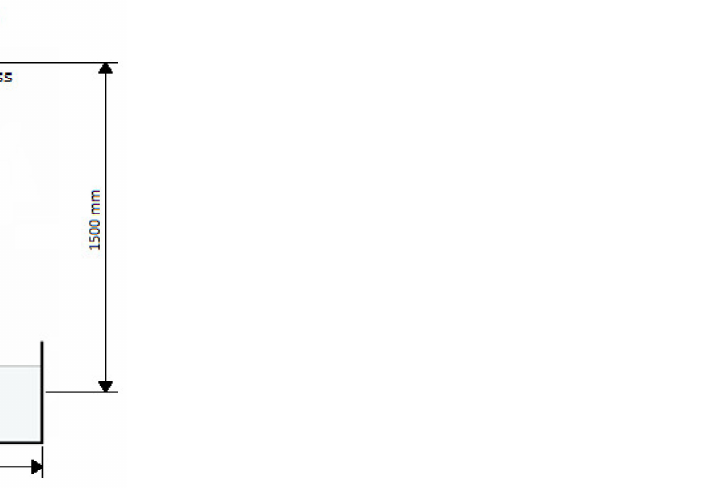
Figure 4. Diagram of the experimental test of the fine aggregate (own elaboration based on [32]). The capillary suction test was carried out on basalt fine aggregate, from which 3 differ- ent samples were taken in order to conduct the capillary suction test.